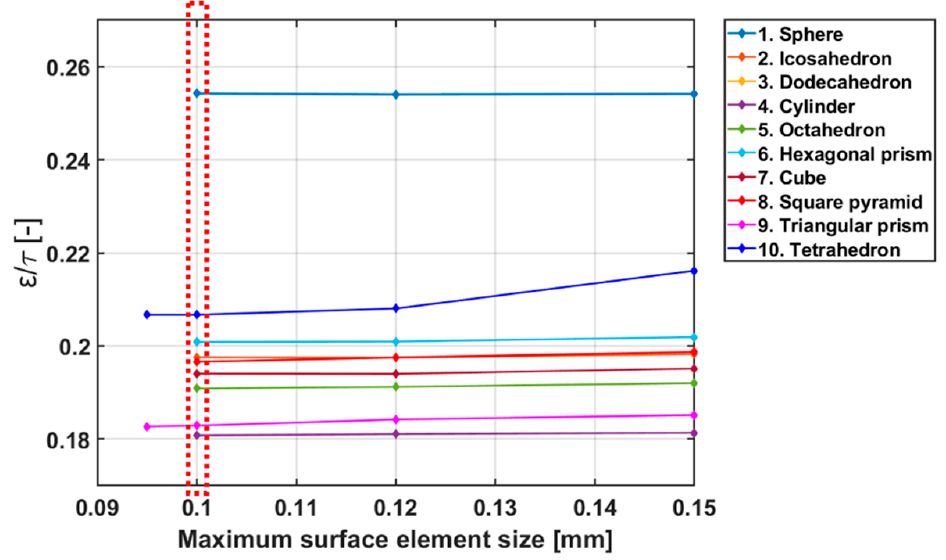
Figure 5. Mesh independence study; dotted red represents the region where results are independent of the mesh size for all particle shapes.